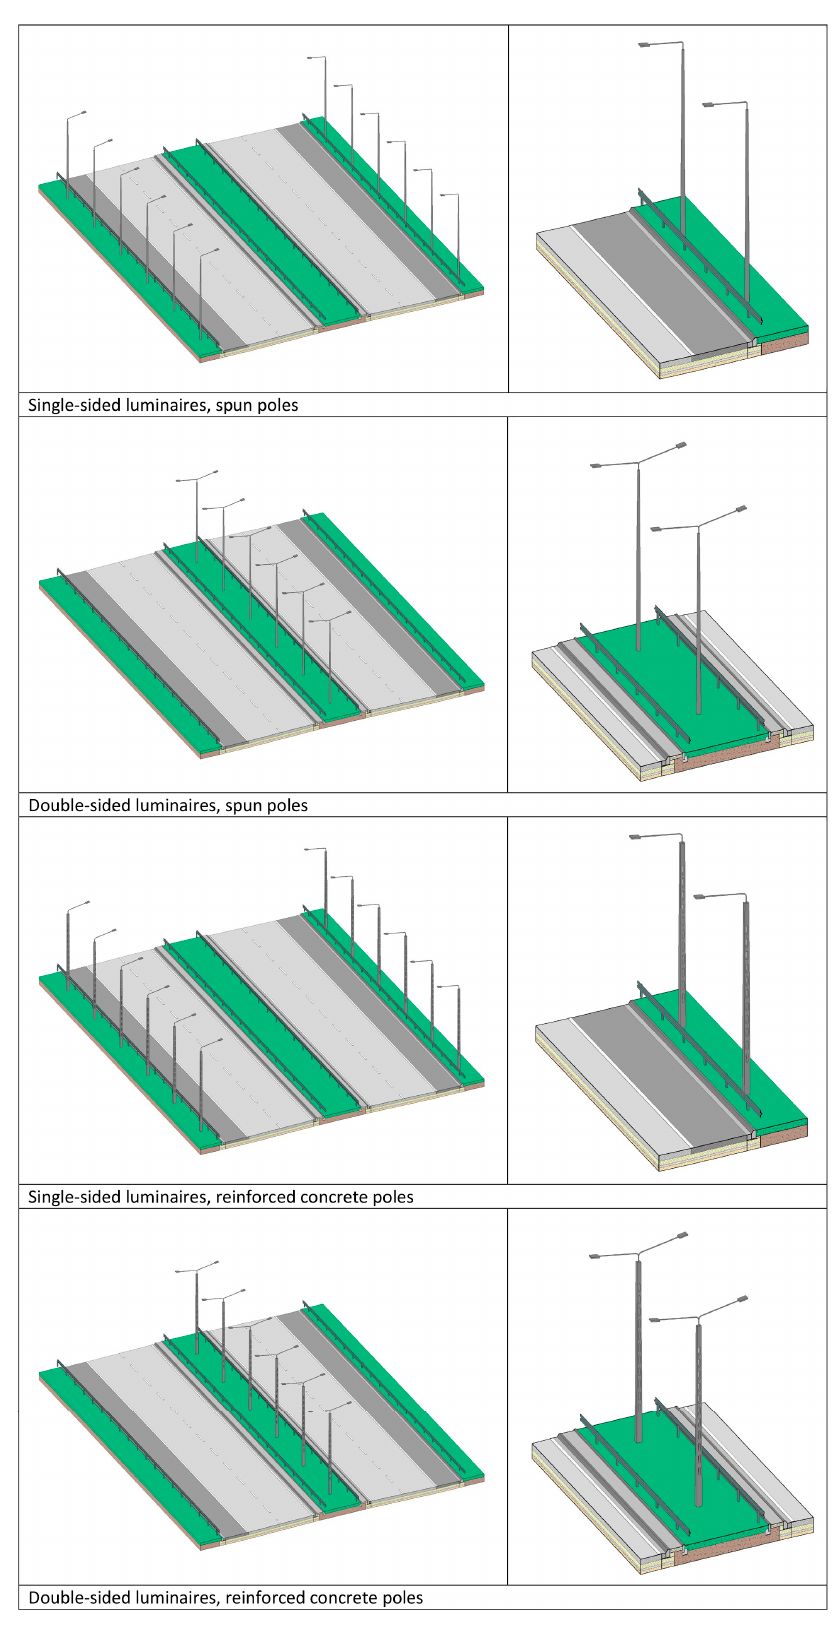
Figure 3. Design variants for spun and reinforced concrete poles with single-sided and double-sided luminaires (source: original work).